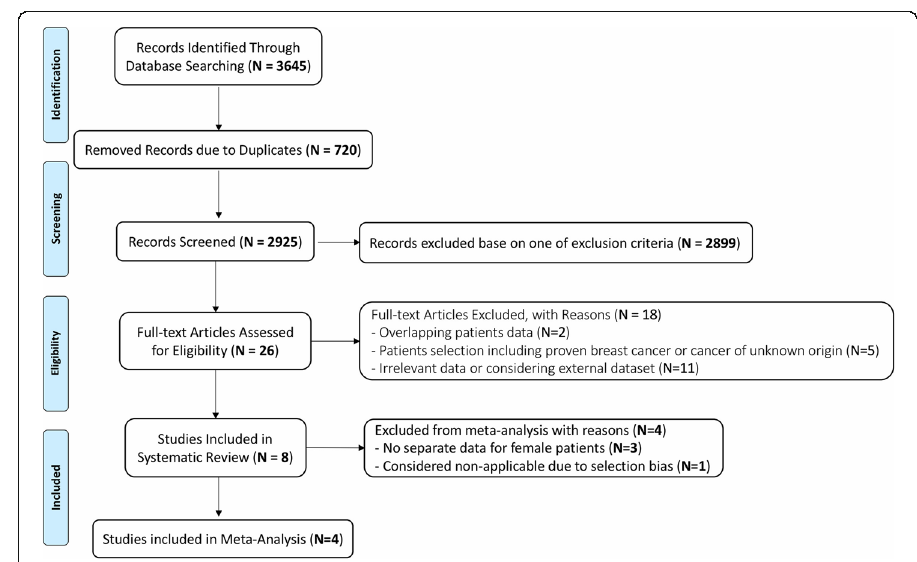
Fig. 1 Flowchart of the search process and study